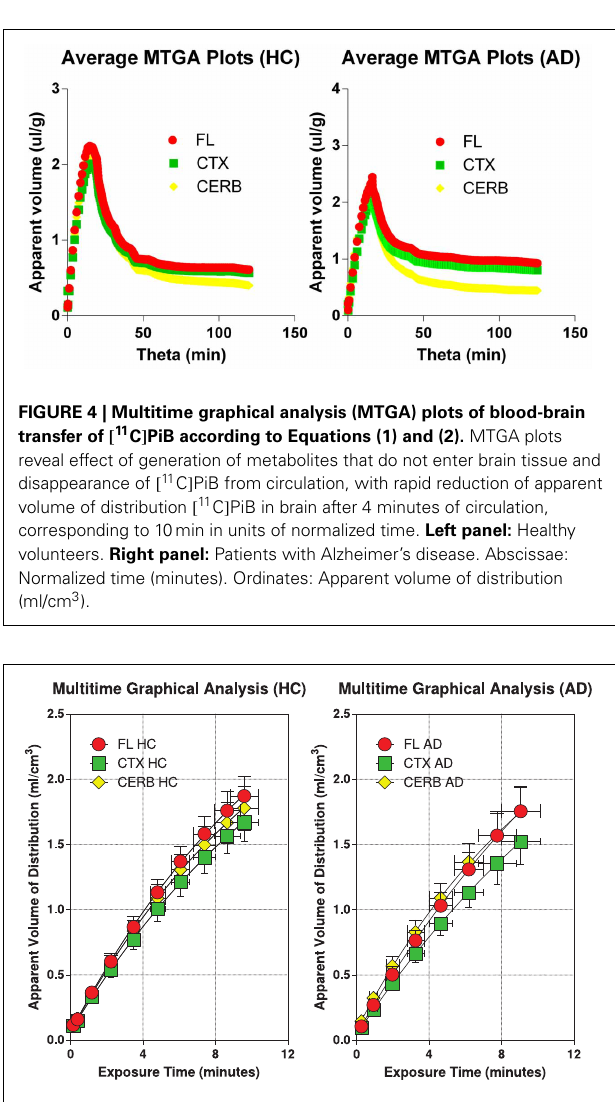
FIGURE 5 | Individual MTGA or Gjedde-Patlak plots with regression curves according to Equations (1) and (2) for 6 healthy volunteers (left panel), and 5 patients with Alzheimer’s disease (right panel). Abscissae: Exposure or ‘Theta’ (defined in Equation 2) (“normalized”) time (minutes). Ordinates: Apparent volume of distribution (ml/cm 3